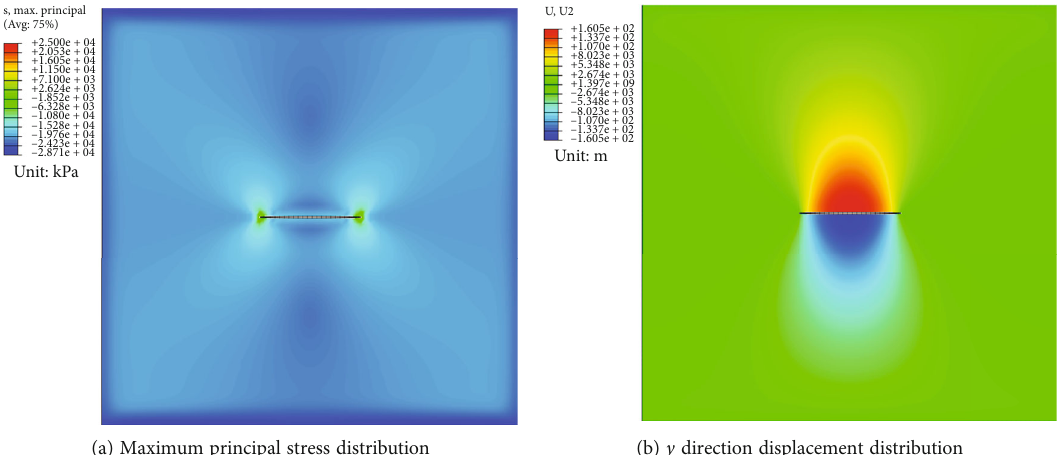
Figure 4: Hydraulic fracture propagation in a homogeneous reservoir ( t = 112 : 2 s).